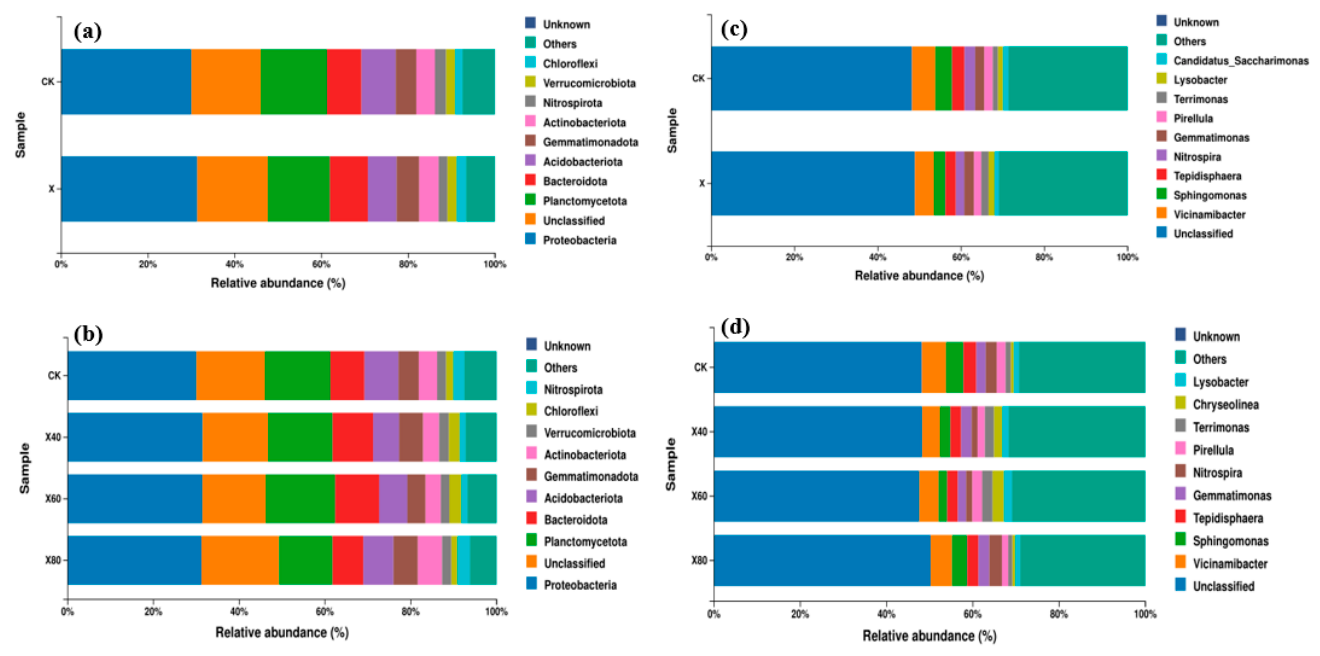
Figure 6. Changes in bacterial taxonomic composition at the phylum ( a , b ) and genus ( c , d ) level under CK, X40, X60, and X80 patterns.